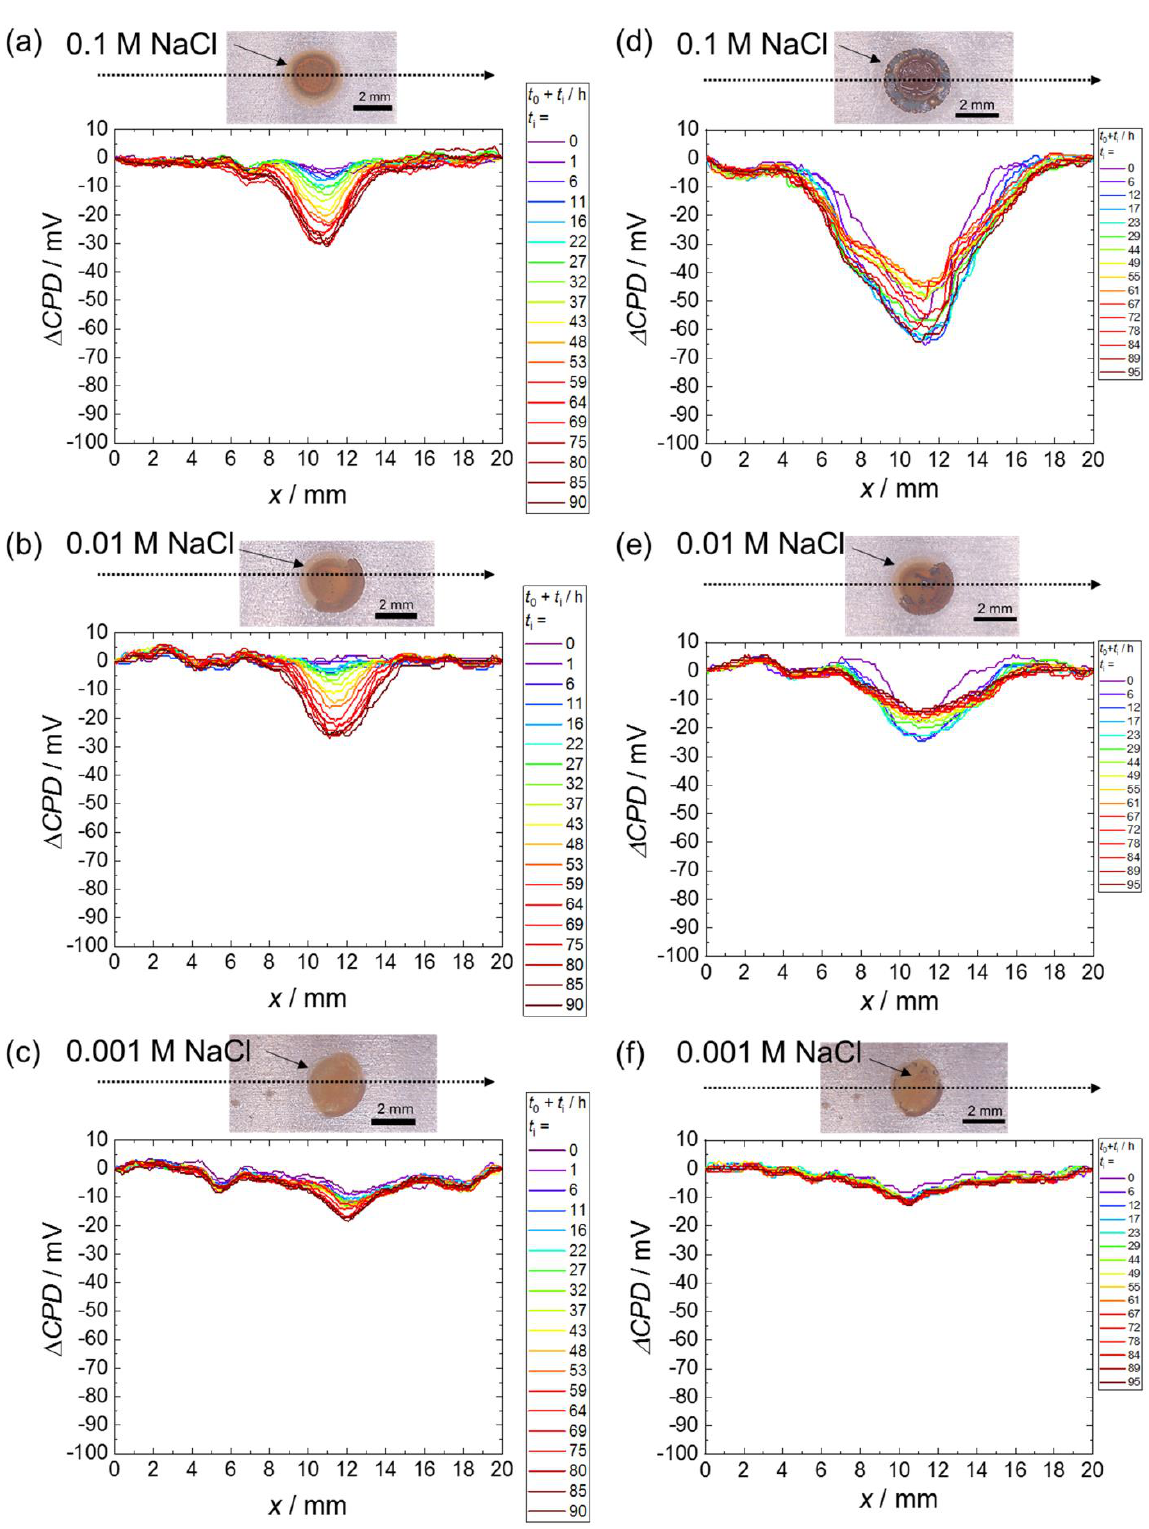
Figure 2. CPD line profiles in x-direction at y-position of CPD min after background subtraction ( ∆ CPD values) measured up to 90 h after application of ( a ) 0.1 M, ( b ) 0.01 M, and ( c ) 0.001 M NaCl aq in comparison with corresponding results after rewetting of the droplets ( d – f